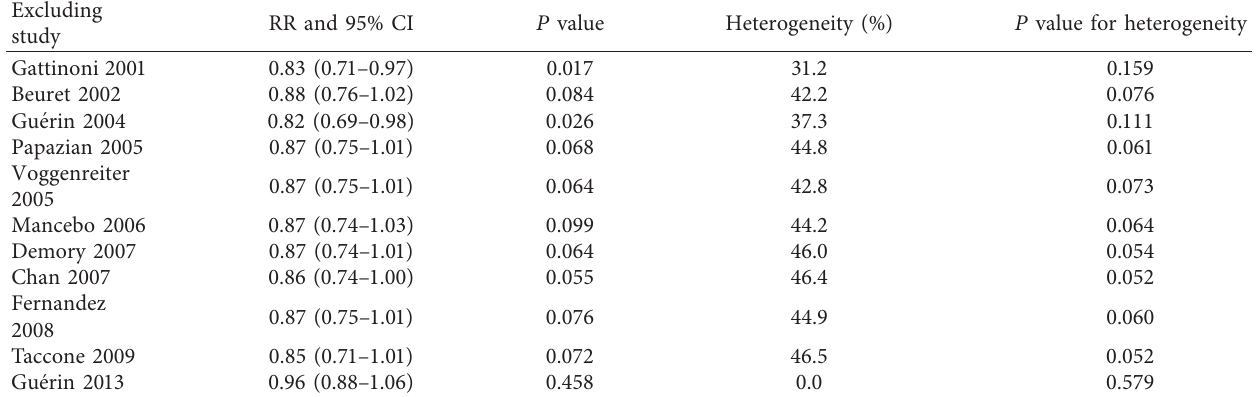
Table 2: Sensitivity analysis for